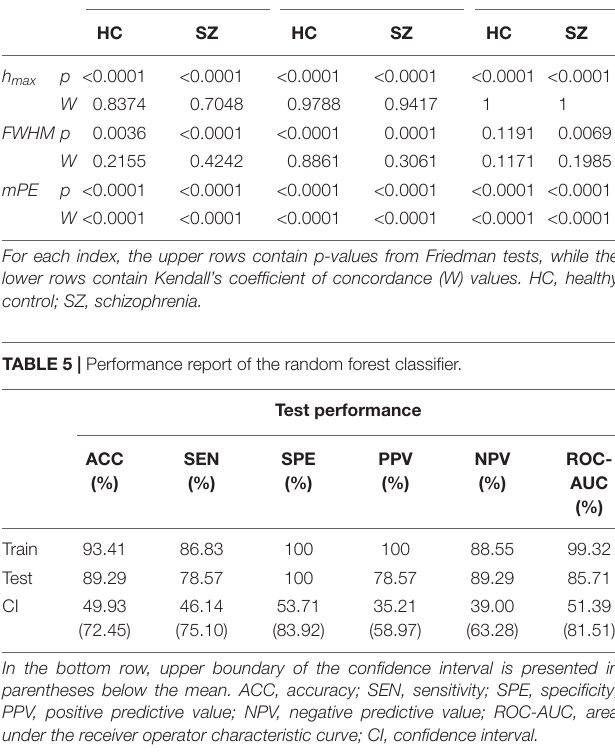
TABLE 6 | Feature importances extracted from the random forest classifier. TABLE 4 | Effect of cost on the multifractal measures (hmax and FWHM) and modified permutation entropy (mPE) of dynamic network theoretical measures. Rank Feature Connectivity strength Clustering coefficient Global efficiency